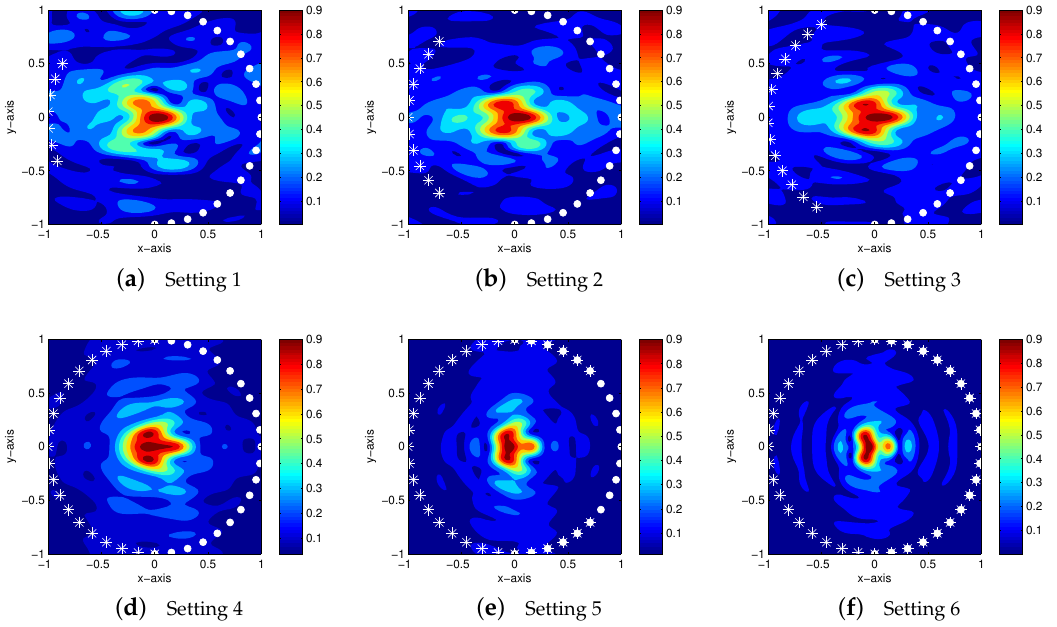
Figure 5. Maps of f SM ( x ) . White colored marks o and (cid:63) denote the incident and observation directions,